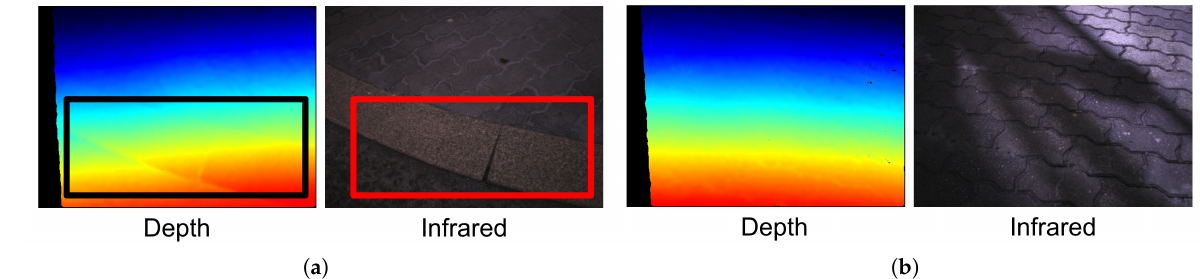
Figure 2. Recording route.